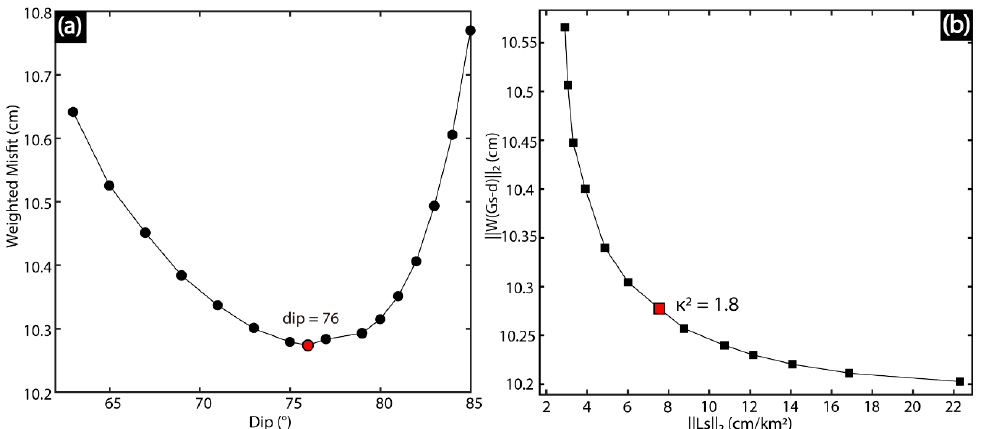
Figure 5. ( a ) Weighted misfit for testing different dip angles of the inverted fault plane. The optimal dip angle is denoted by a solid red circle. ( b ) Trade-off curve between the roughness of the model and the weighted data misfit. The red square is the optimal Laplacian smoothing factor in the inversion. Remote Sens. 2019 , 11 , x FOR PEER REVIEW